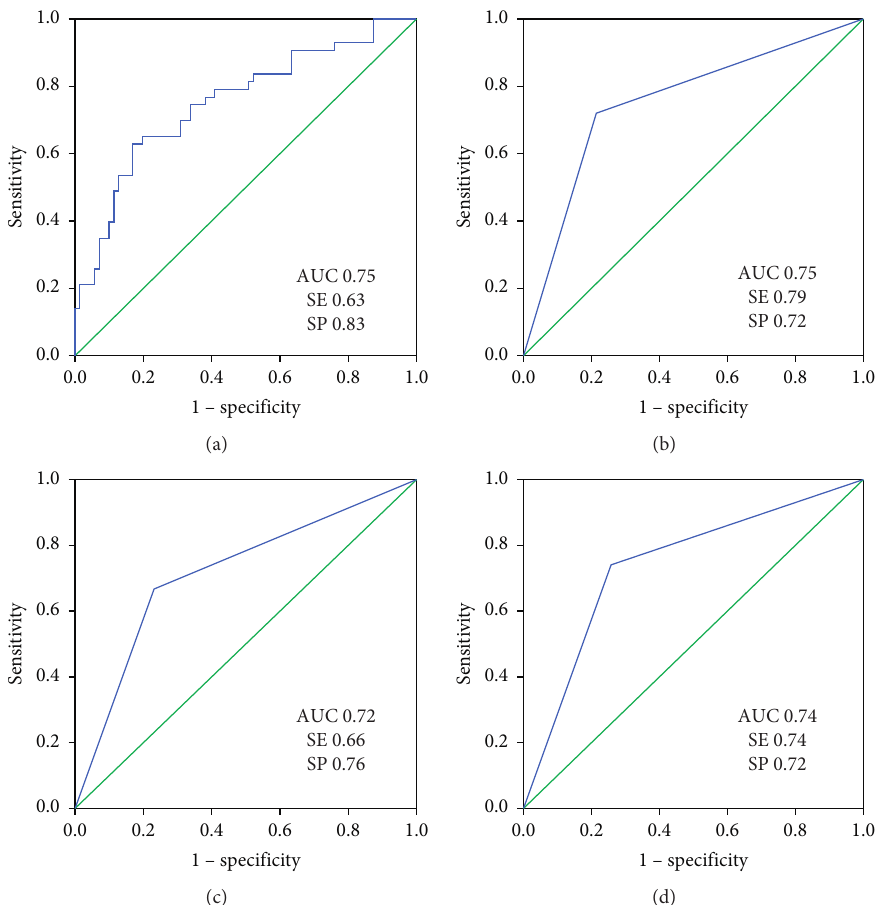
Figure 4: Receiver operating characteristic curve of the development cohort and validation cohort. (a) Logistic regression model de- velopment, (b) logistic regression model validation, (c) classification tree model development, and (d) classification tree model validation; AUC: area under the curve; SE: sensitivity; SP: